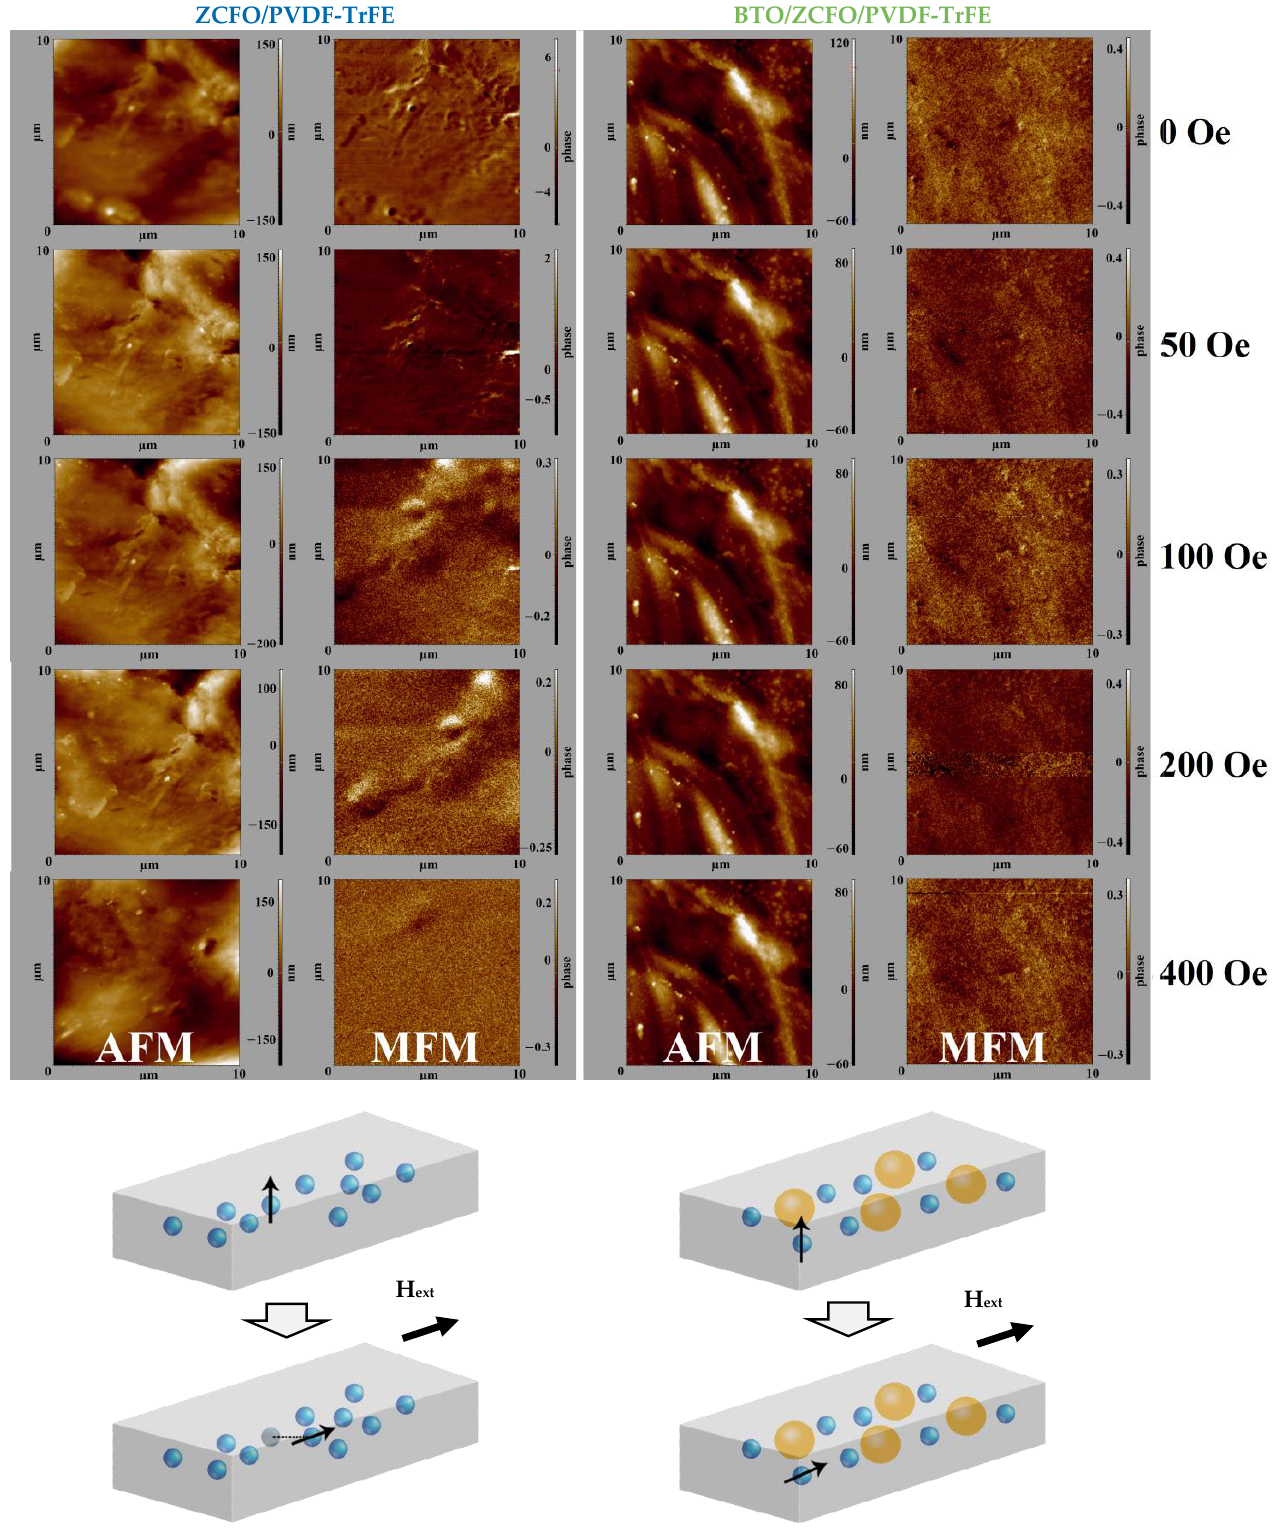
Figure 5. AFM-MFM images of ZCFO/PVDF-TrFE and BTO/ZCFO/PVDF-TrFE samples under application of magnetic field H = 0, 50, 100, 200 and 400 Oe.